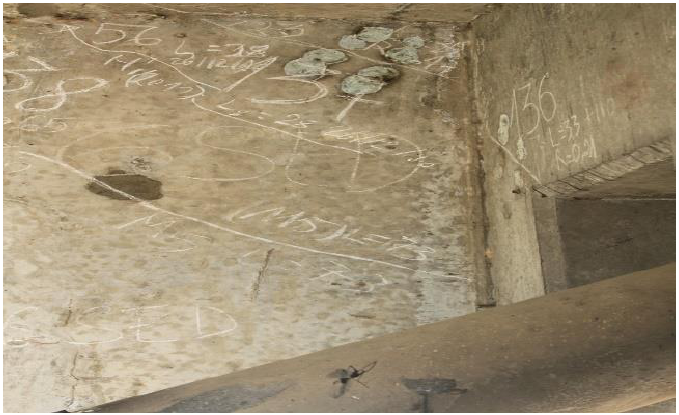
Figure 16. Examples of localized concrete cracks within the compression cables on My Thuan Bridge.